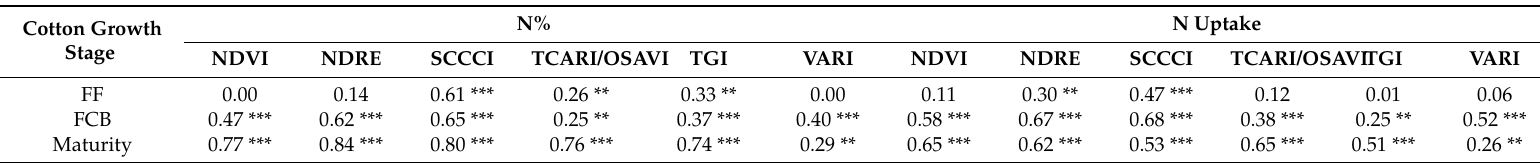
Table 4. Coefficient of determination (r 2 ) for the relationships obtained between mean nitrogen uptake (N uptake, kg N ha − 1 ) and above-ground plant N concentration (N%) with the normalized difference vegetation index (NDVI), the normalized difference red edge index, NDRE, the simplified canopy chlorophyll content index (SCCCI), the transformed chlorophyll absorption reflectance index normalized by the optimized soil adjusted vegetation index (TCARI/OSAVI), the triangular greenness index (TGI) and visible atmospherically resistant index (VARI) at first flower (FF), first cracked boll (FCB) and maturity. Cotton Growth